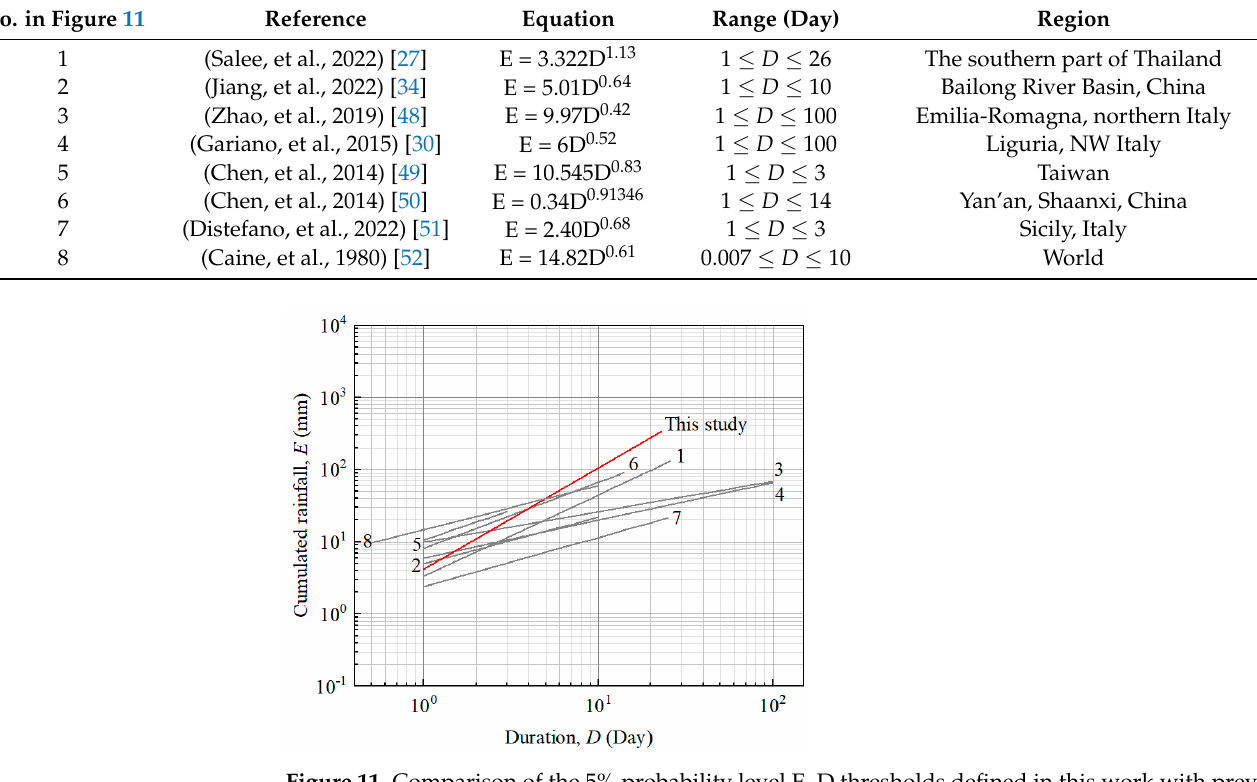
Figure 11. Comparison of the 5% probability level E–D thresholds defined in this work with previ- ously published thresholds. The numbers refer to the numbers in Table 3.